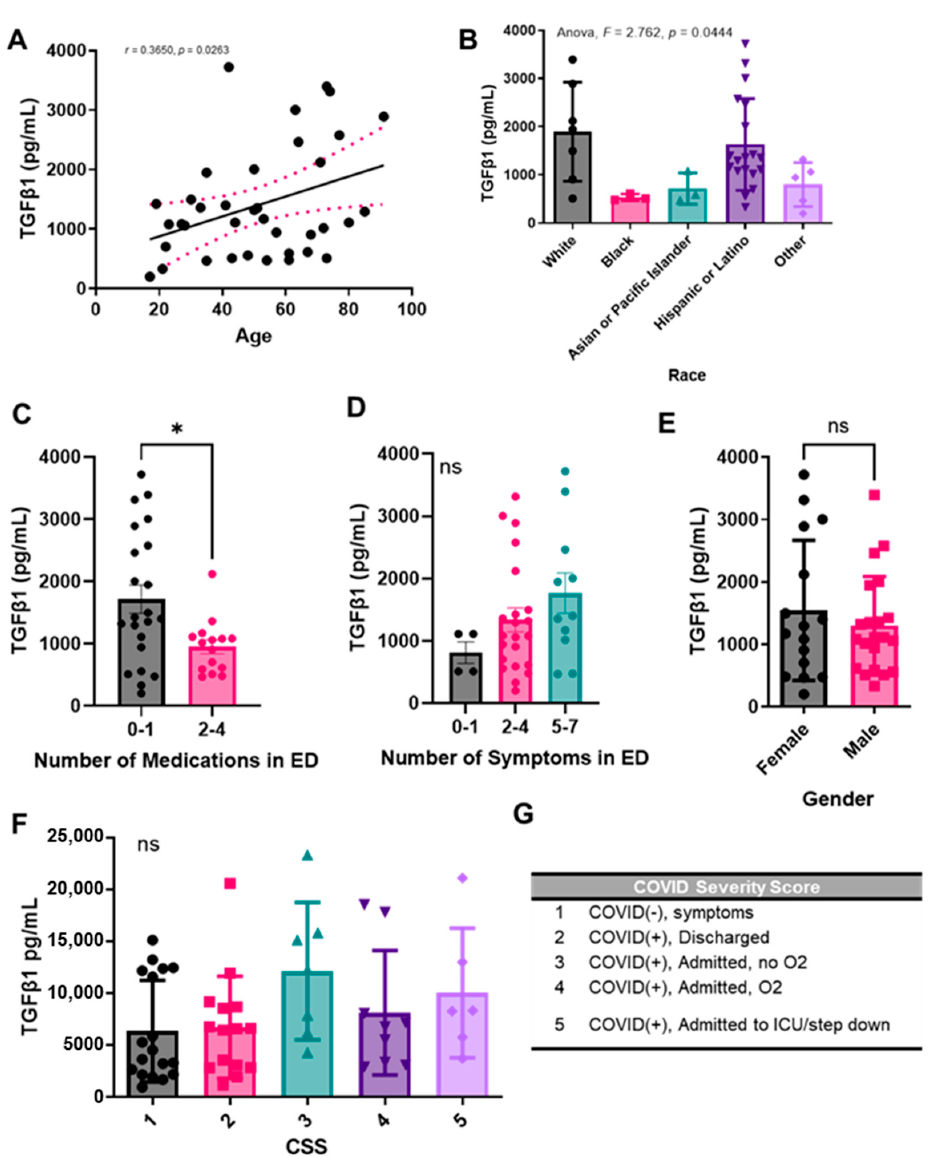
Figure 3. Plasma TGF- β 1 levels correlate with age, race, and number of medications administered upon presentation with COVID-19 to the ED, but not with sex. Total TGF- β 1 levels were detected in activated plasma samples. TGF- β 1 plasma concentration correlation with ( A ) age, ( B ) race, ( C ) number of medications administered upon presentation with COVID-19 to the emergency department (ED), ( D ) number of symptoms reported upon presentation to the ED, ( E ) sex, or ( G ) COVID-19 severity score. ( G ) COVID-19 severity score (CSS) legend. Sample values are reported in pg/mL (n = 81 samples). Statistical significance was calculated using: ( A ) Spearman’s correlation, ( B , D , F ) One-way Anova followed by a post hoc Tukey’s multiple comparisons test, and ( C , E ) two-tailed, unpaired Student’s t-test. The minimal level of significance was p < 0.05. Bar graphs represent the mean of the population, and error bars indicate standard deviation. * represents p < 0.05.